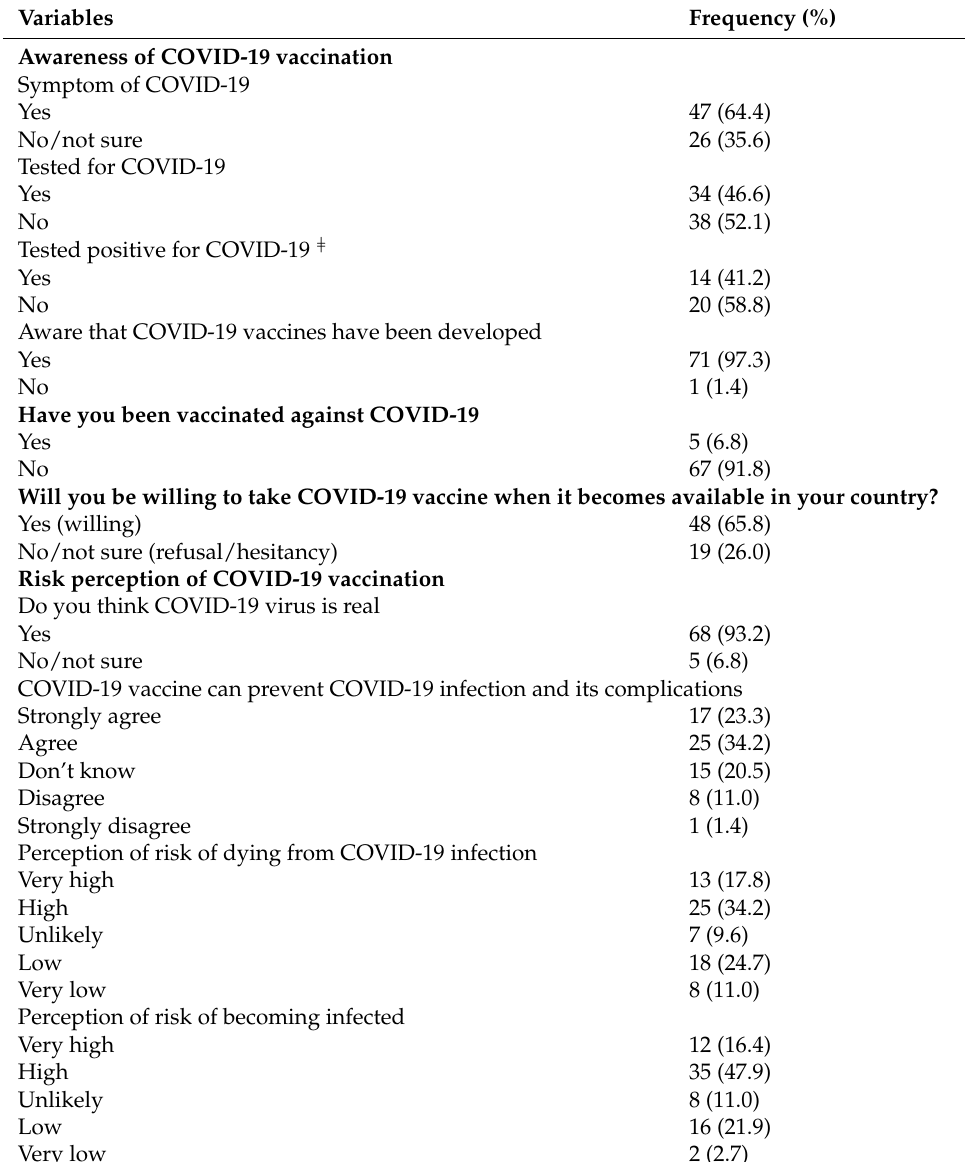
Table 3. Awareness and risk perception of COVID-19 vaccine among study